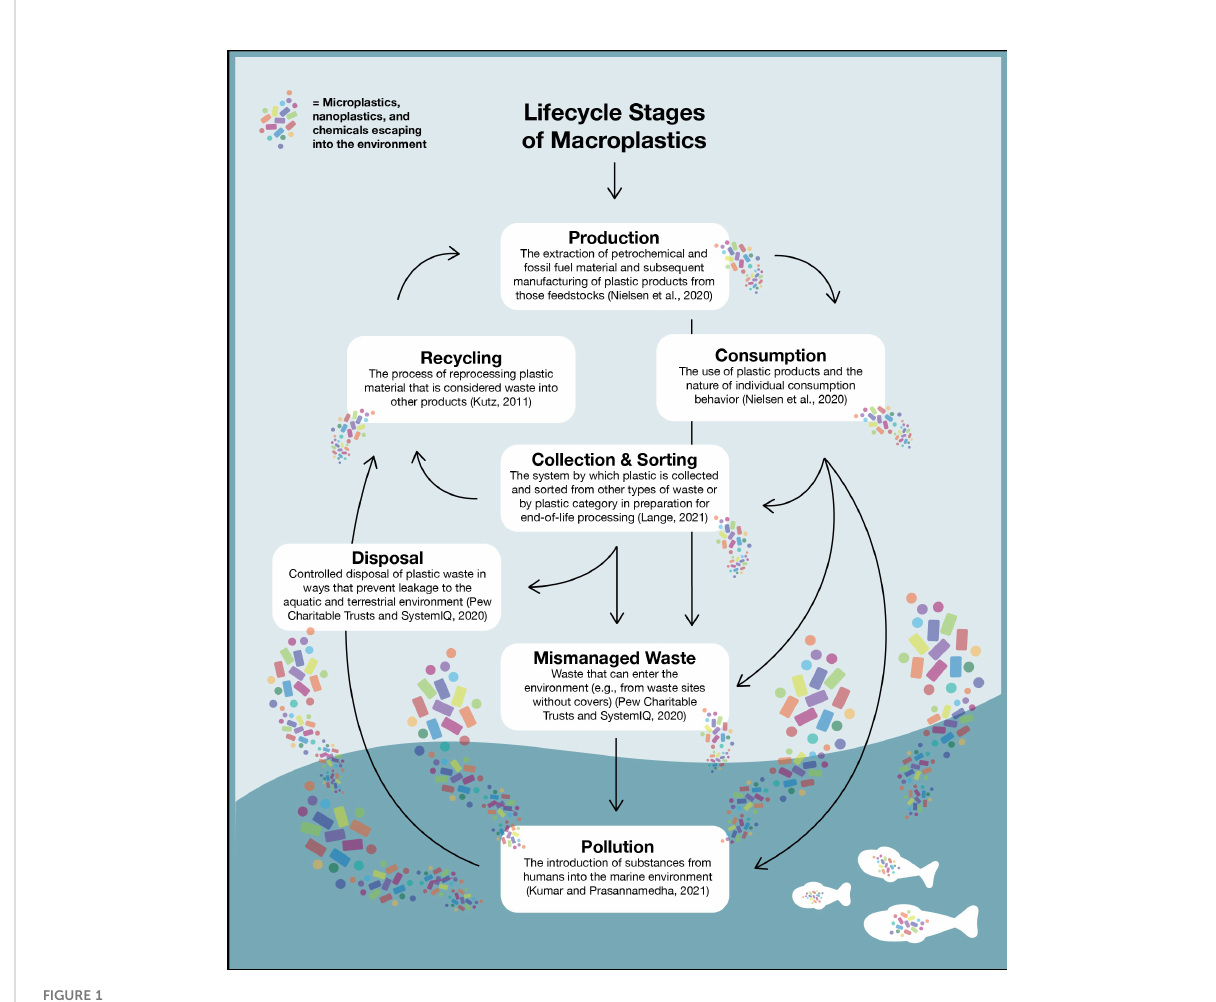
FIGURE 1 Stages of the macroplastic